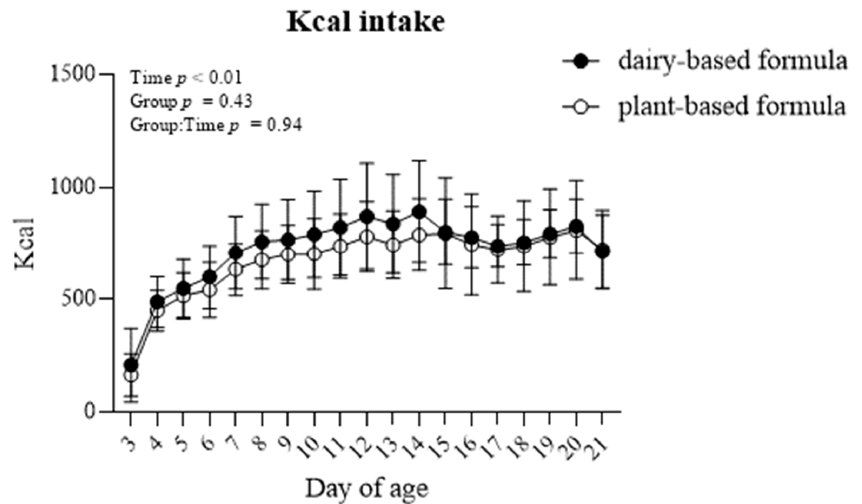
Figure 2. Average formula intake (Kcal) per day of piglets fed either a dairy-based (Similac Advance powder) or a plant-based (Else nutrition powder) formula ( n = 9/group) from postnatal day (PND) 2 until PND 21.